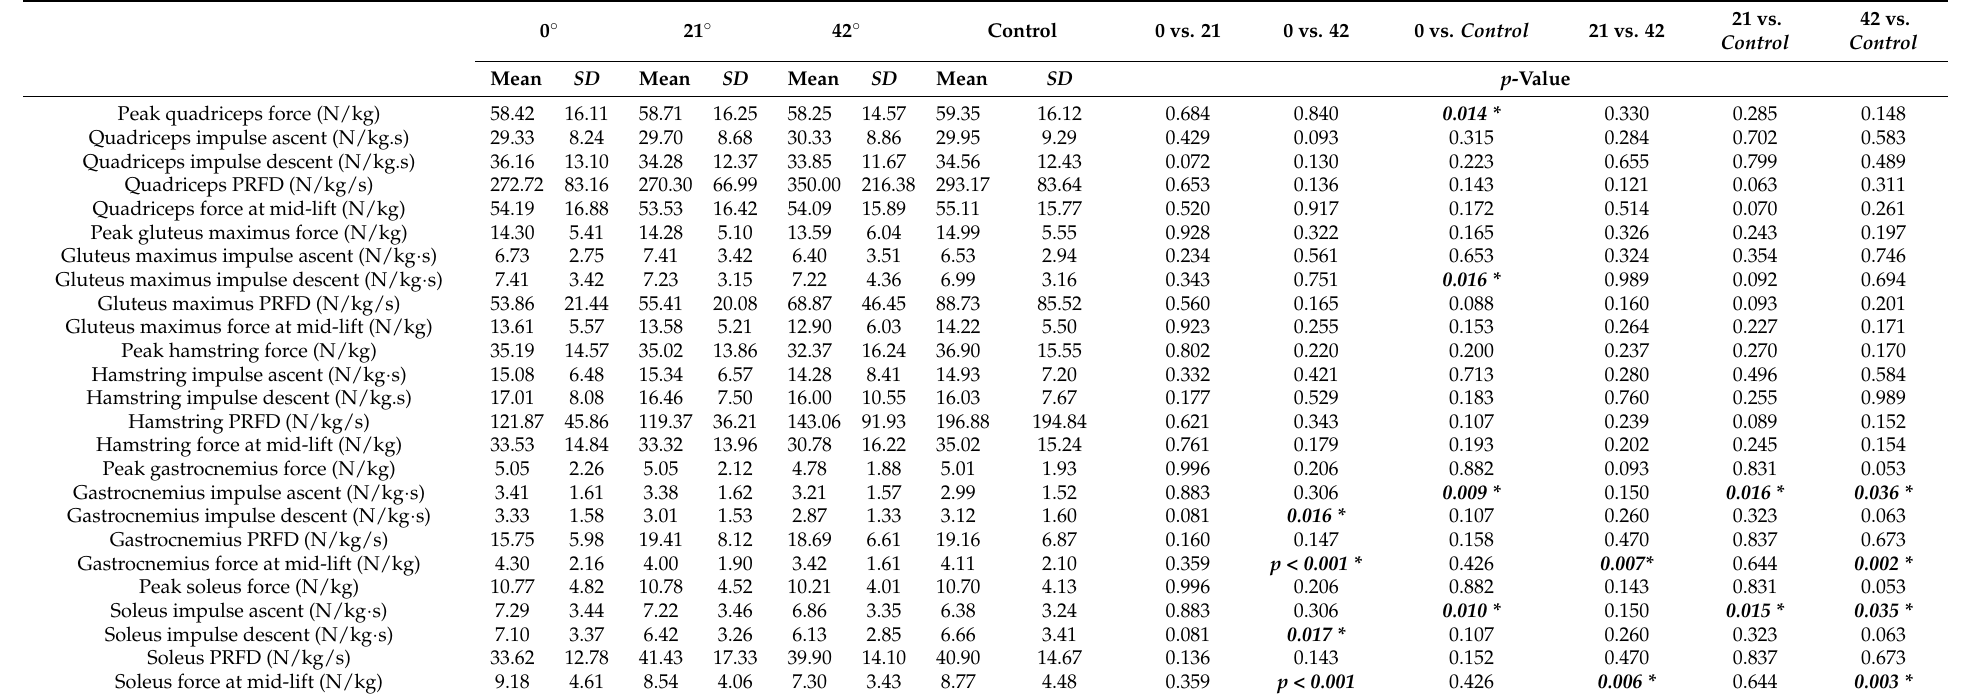
Table 6. Muscle forces (mean ± SD) and statistical comparisons as a function of each experimental